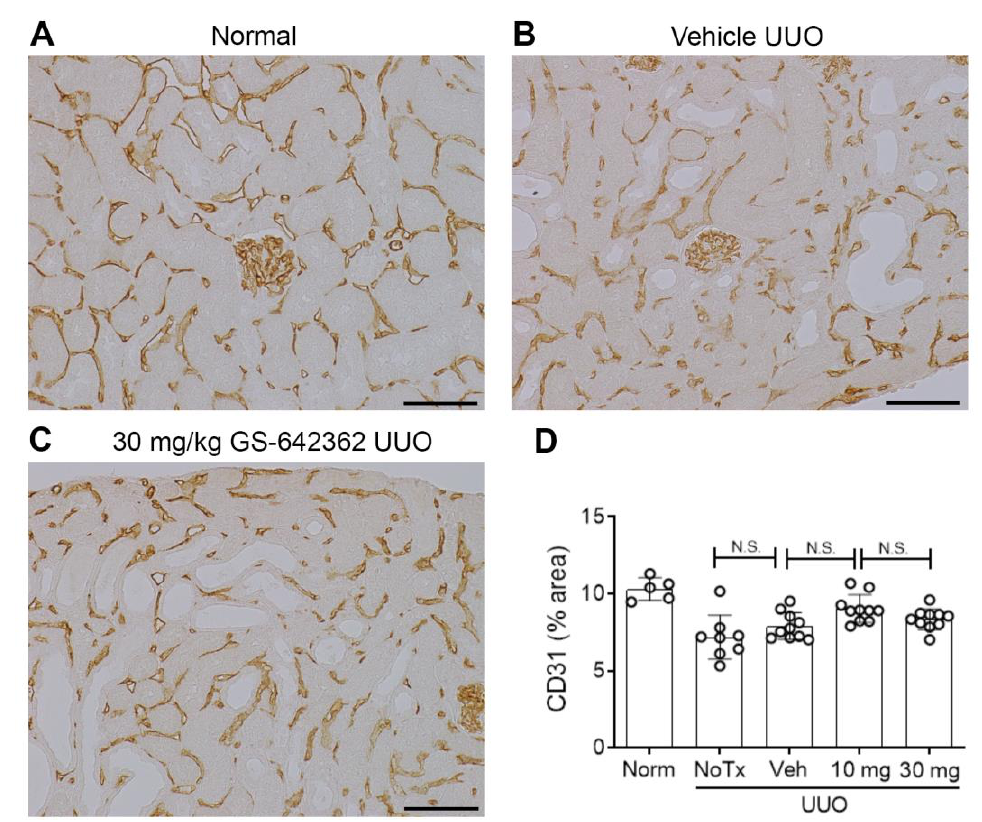
Figure 9. Peritubular capillary loss in the day 7 unilateral ureteric obstruction (UUO) model (n = 8 to 10/group). ( A – C ) Immunostaining for CD31+ endothelial cells. ( A ) Normal kidney shows a dense network of peritubular capillaries and glomerular capillary tufts. ( B ) Vehicle-treated UUO shows a partial loss of peritubular capillaries. ( C ) UUO treated with 30 mg/kg GS-642362 also shows a partial loss of peritubular capillaries. Bar = 100 µ m. ( D ) Graph of the area of interstitial CD31 staining. N.S., not significant.